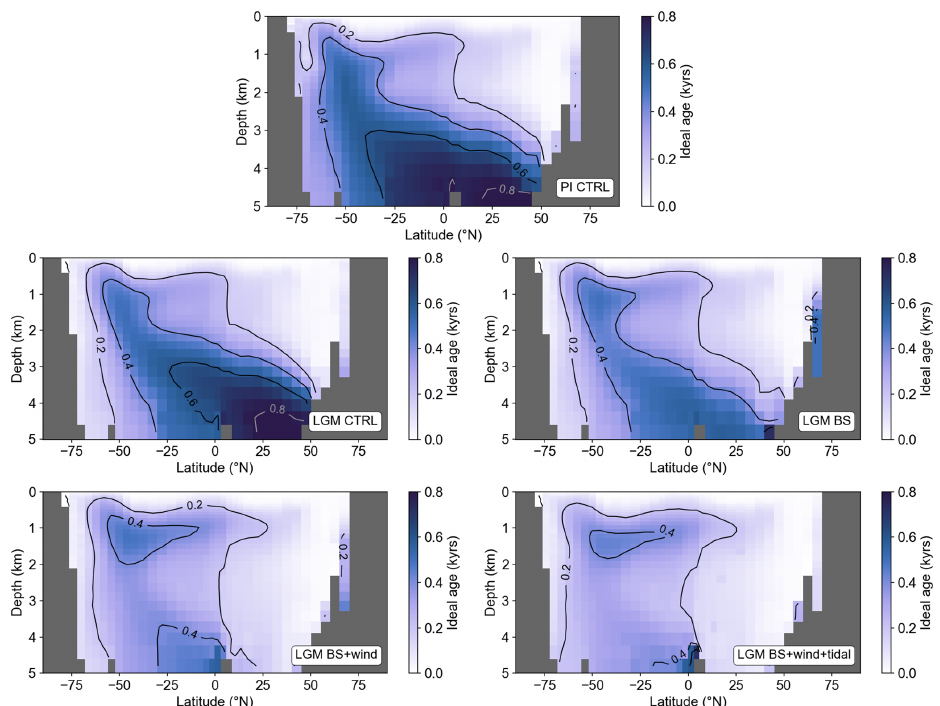
Figure B3. Zonally averaged ideal water ages of the Atlantic for the different model configurations listed in Table 1. Ideal ages are set to zero at the surface and increase in the ocean interior at a rate of 1yryr − 1